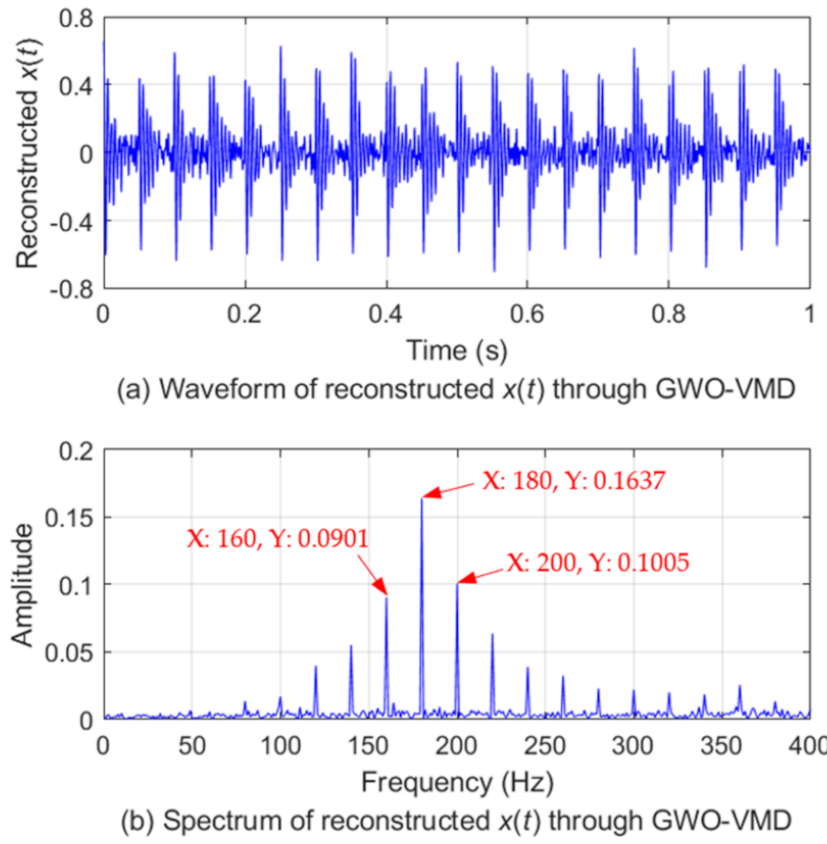
Figure 7. Reconstructed experimental signal and its spectrum through GWO-VMD.